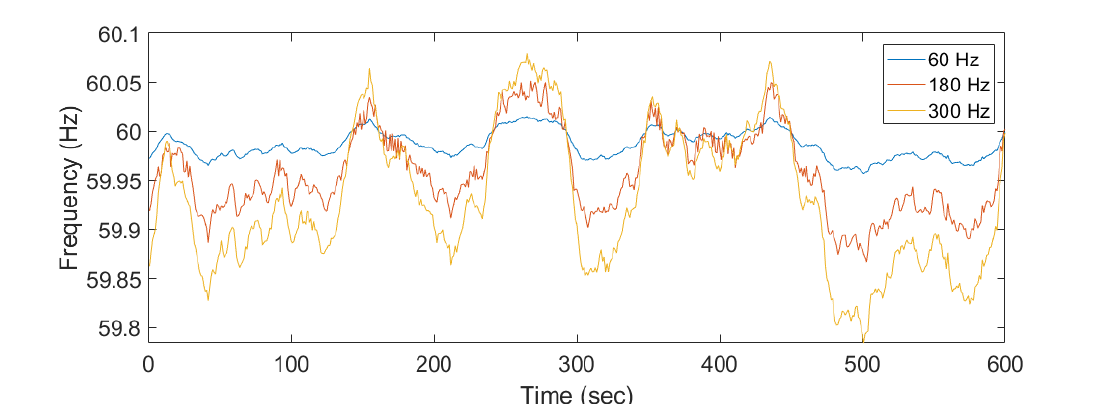
Figure 8. Different harmonics of power recording shifted to 60 Hz for